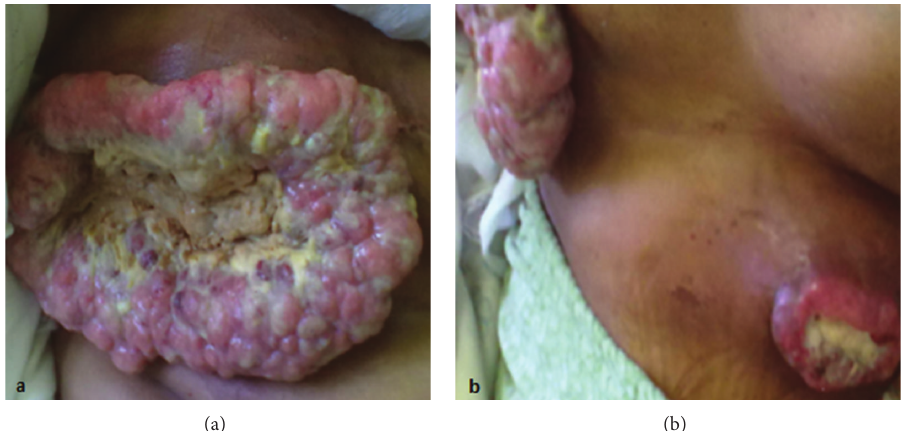
Figure 4: (a) Photograph of local progression of the breast tumor after 3 cycles of the first line chemotherapy and distant apparition of a cutaneous abdominal